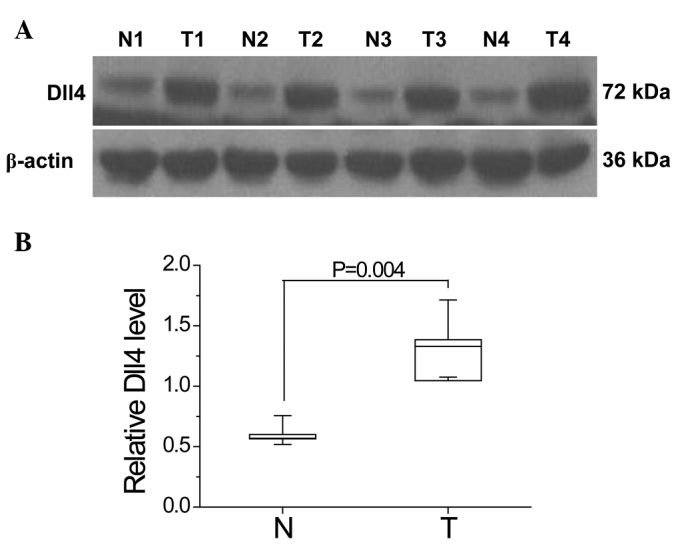
Expression levels of delta-like ligand 4 (Dll4) protein in clear cell renal cell carcinoma (CCRCC; T) and non-cancerous tissues (N), assayed by western blotting. (A) Western blot analysis reveals higher Dll4 expression levels in CCRCC than those in non-cancerous tissues. (B) Quantification of the bands in Fig. 1a using ImageJ software. All Dll4 expression levels were normalized to those of the corresponding internal control (β-actin).